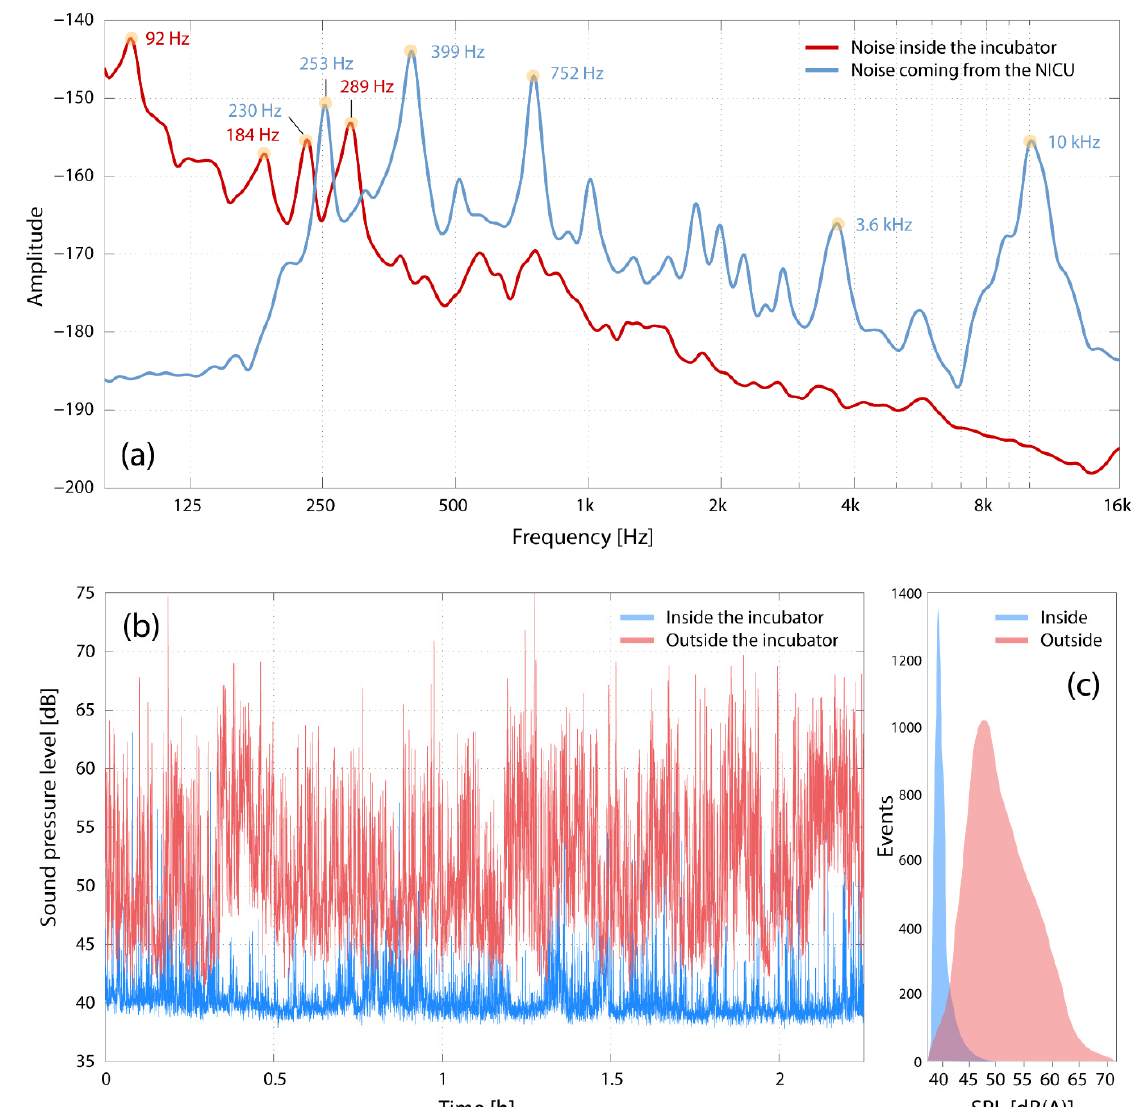
Figure 3. ( a ) Noise spectra recorded inside and outside an incubator located in an NICU. Peak frequencies are indicated at the specific peaks. The recording was done in an NICU with several incubators working and under normal clinical working conditions. ( b ) Time-series of SPL variations over about 2 h, measuring inside and outside an incubator. ( c ) Distribution of SPL values shown in ( b ).